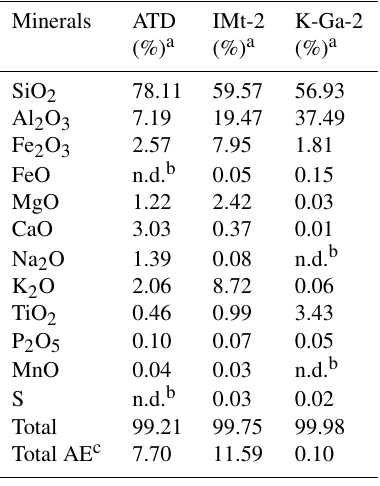
Table 2. Chemical compositions of the ATD dust and standard clays. Minerals